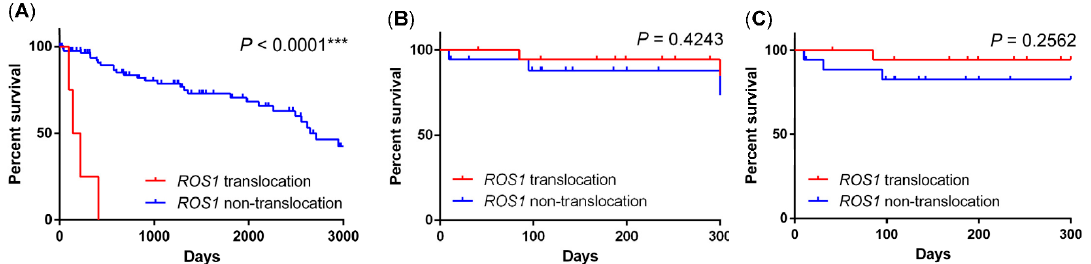
Figure 6. Overall survivals of non-small cell lung cancers treated with different treatment modalities. The overall survival of ROS1 translocated lung cancers had a poor overall l survival as compared to those without ROS1 translocation ( A ) . The crizotinib treatment reverse the poor prognostic outcome from the pre-crizotinib period (( A ), p < 0.0001) to no significant difference in crizotinib stage (( B ), p = 0.4243). The progression-free survival in the post-crizotinib period shows no significant difference between ROS1 translocated cases treated with crizotinib and ROS1 non-translocated cases treated with standard chemotherapy ( C ). *** p < 0.001.